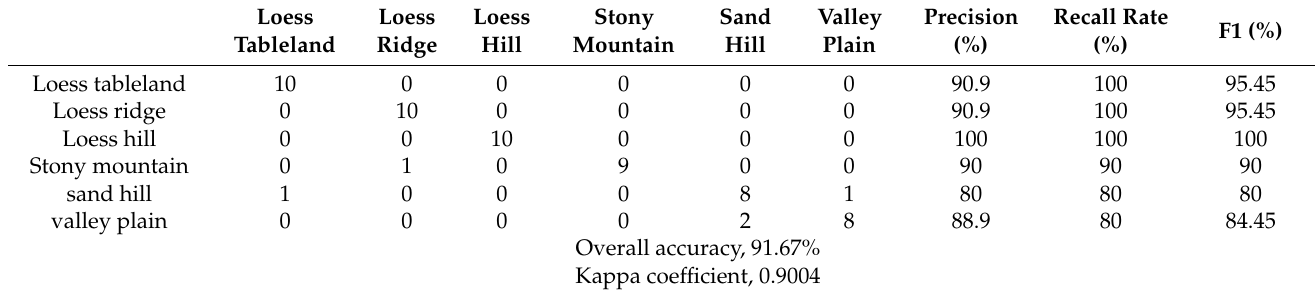
Table 4. The confusion matrix produced by combining the WWCN spatial structure and the P–N terrain spatial structure.